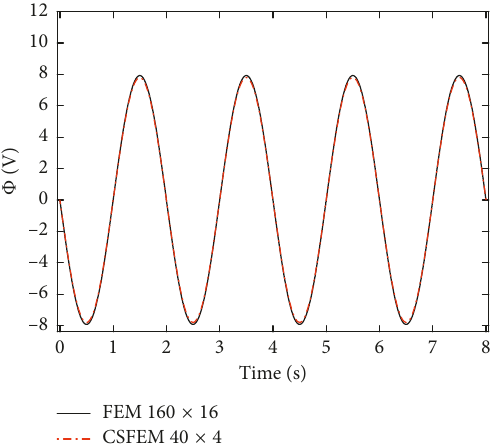
z at point A with respect to time.